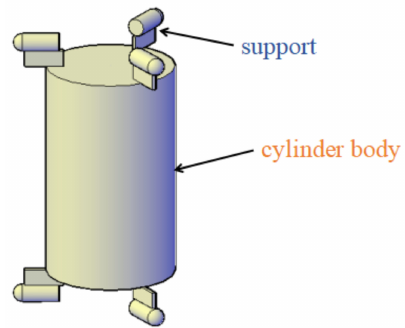
Figure 1. Geometric model of the piped